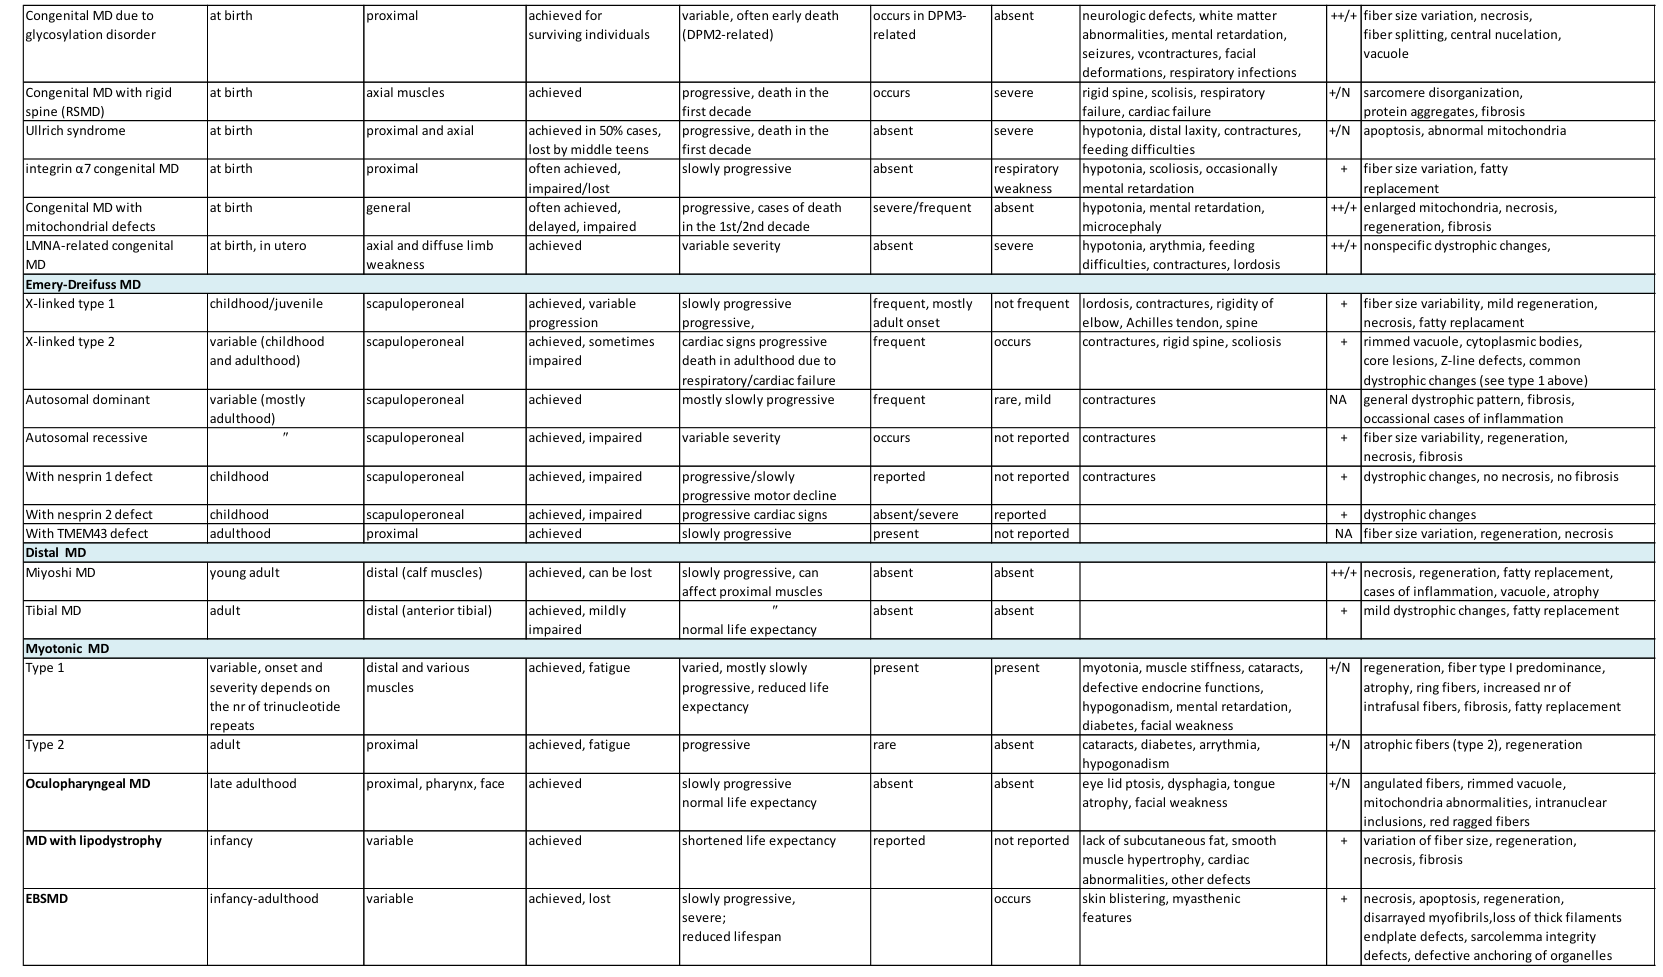
Table 2. Cont. Int. J. Mol. Sci. 2018 , 19 , x FOR PEER REVIEW 8 of